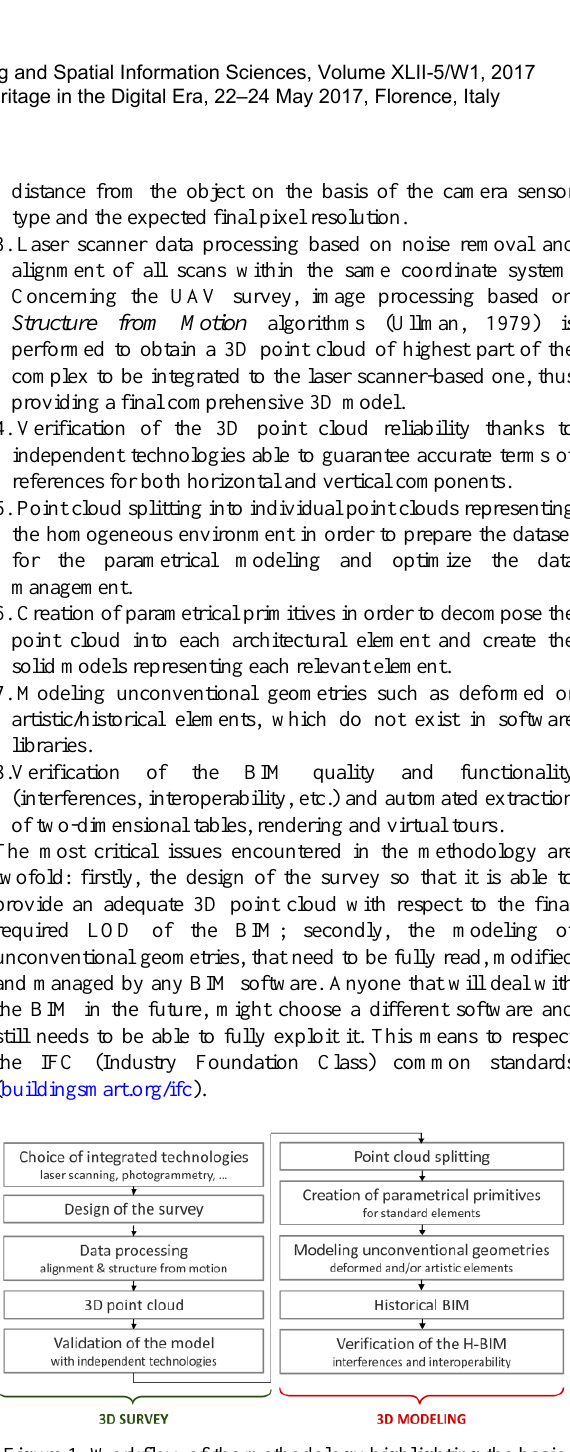
Figure 1. Workflow of the methodology highlighting the